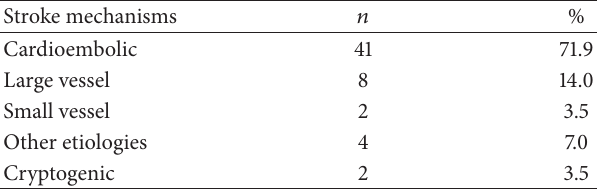
Table 3: Stroke mechanisms.